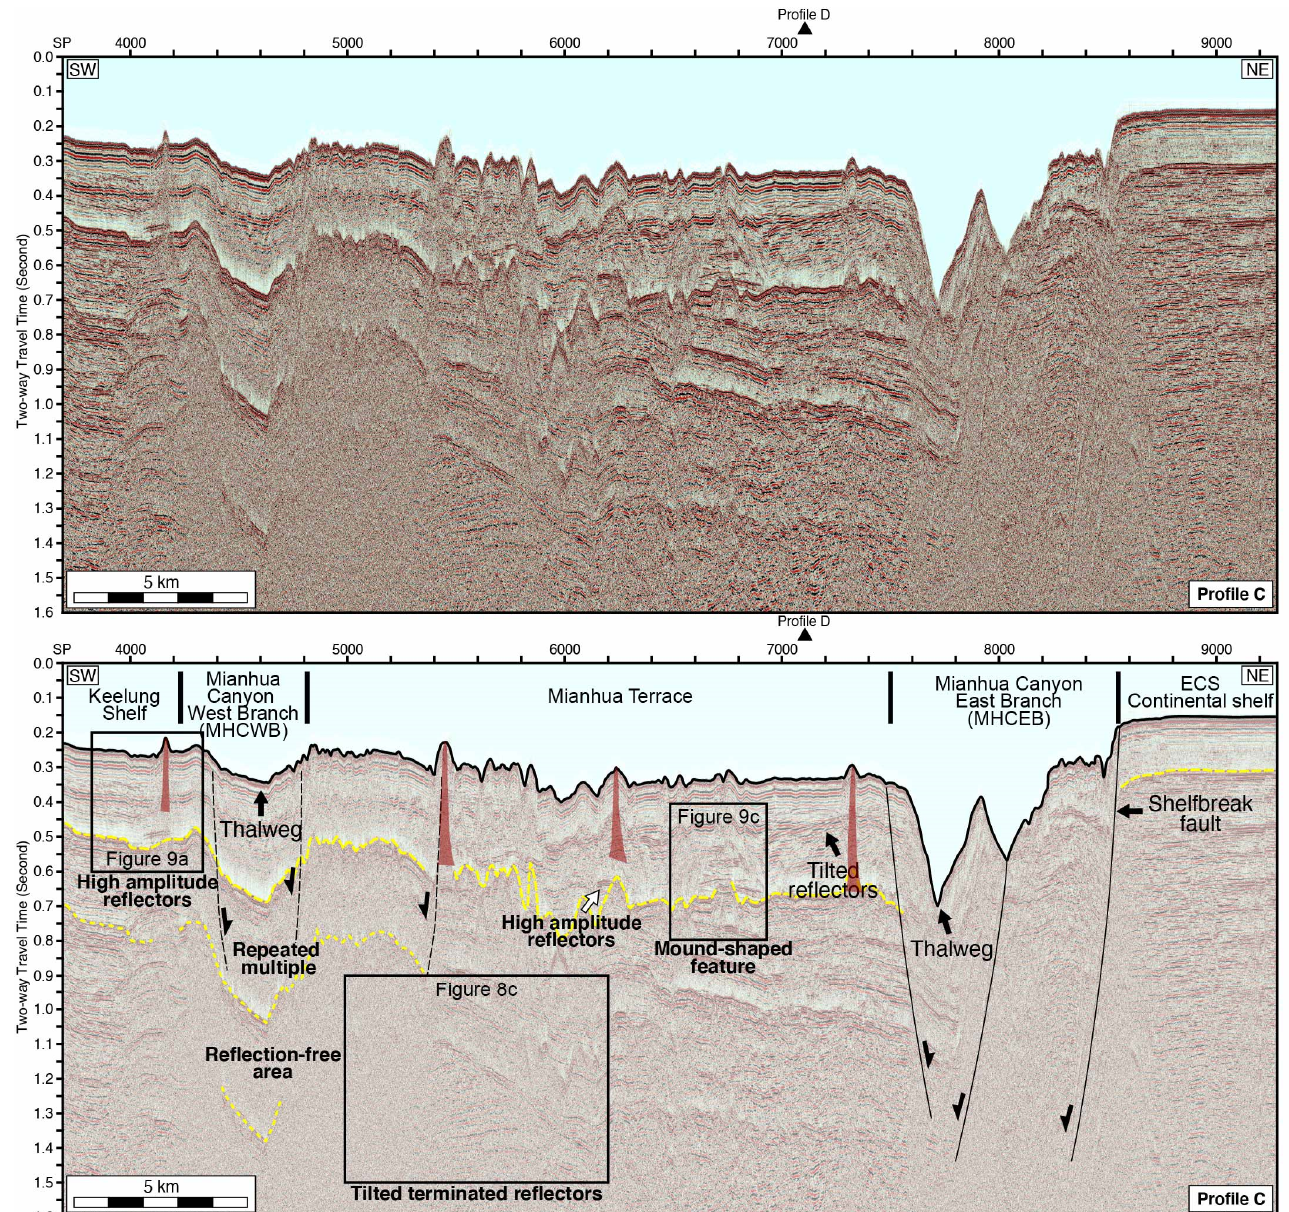
Figure 6. MCS data of Profile C across the Mianhua Terrace in the NE–SW direction. Brown areas indicate the volcanic extrusions. Yellow lines indicate seafloor multiples.